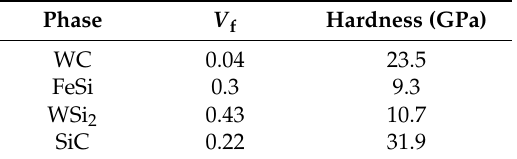
Table 2. Volume fractions of coating phases and corresponding literature hardness